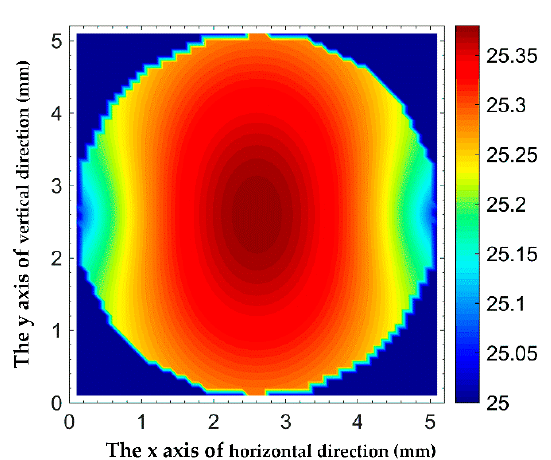
Figure 12. The average temperature profile of the laser rod in the compensated side-pumping scheme.